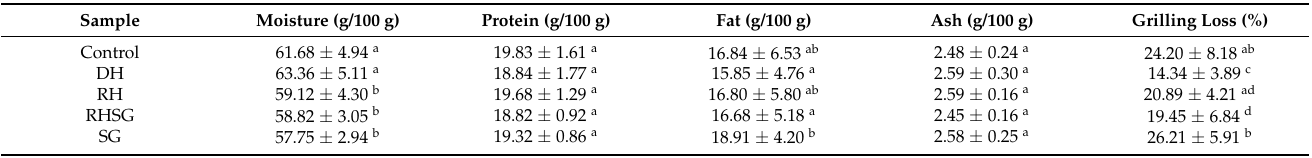
Table 2. Proximate composition of grilled pork patties and grilling losses. Values are least square means ± standard